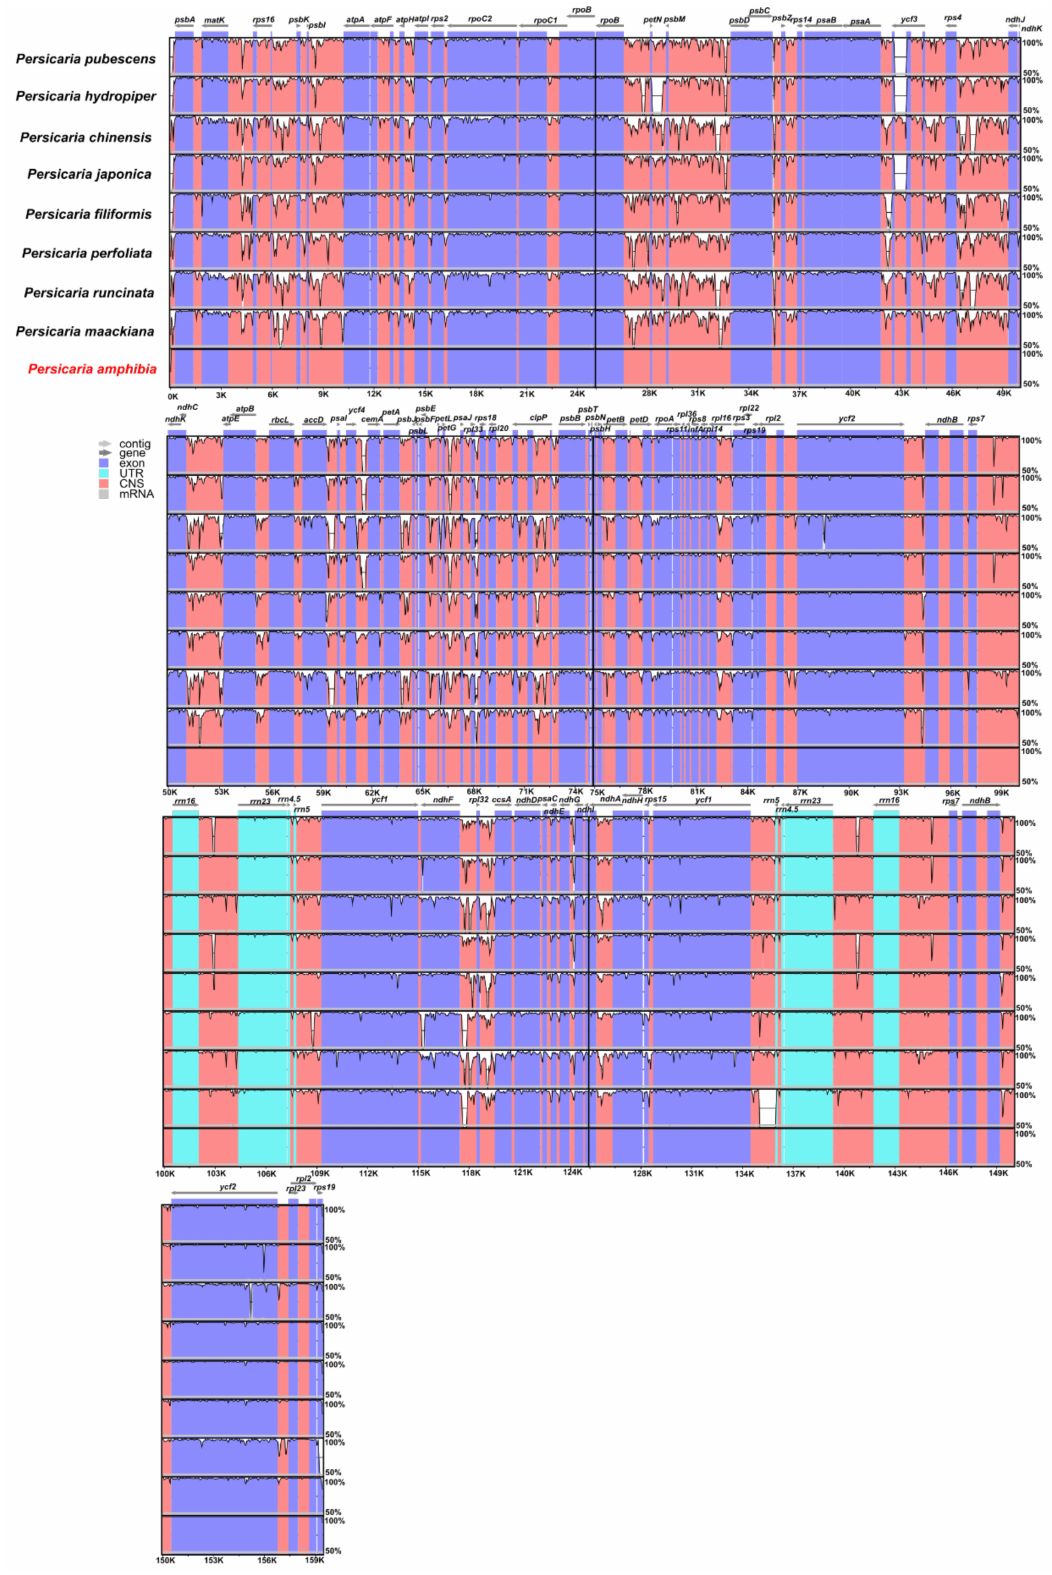
Figure 5. Visualization of the alignment of the 9 Persicaria chloroplast genomes. The top grey arrow shows genes in order and the position of each gene. The blue and sky boxes indicate protein-coding genes and